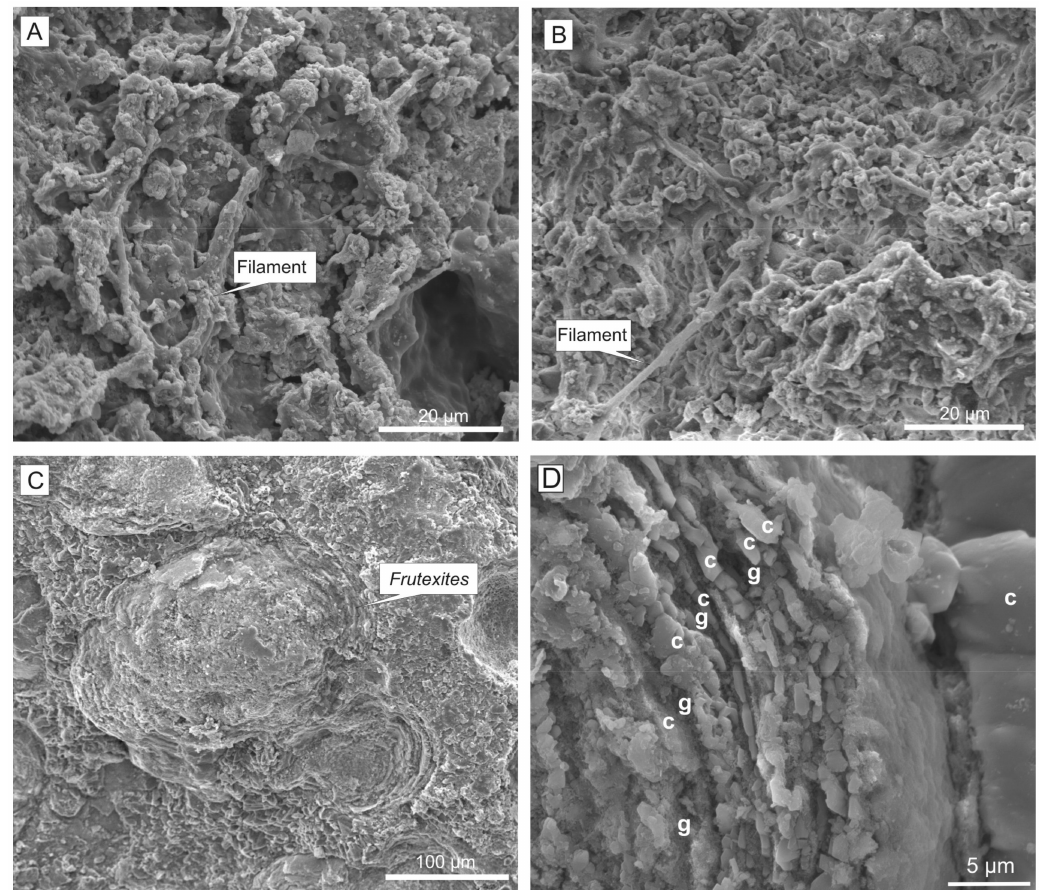
Figure 13. SEM images of fossil microbial structures registered inside of iron crusts developed on the Bathonian hardground ( A , B ) and Frutexites from neptunian-dykes ( C , D ) (Central External Subbetic). ( A , B ) Webs of branched filaments. ( C ) General view of Frutexites . ( D ) Detail of the alternance of calcite (c) and goethite (g) laminae composing the Frutexites